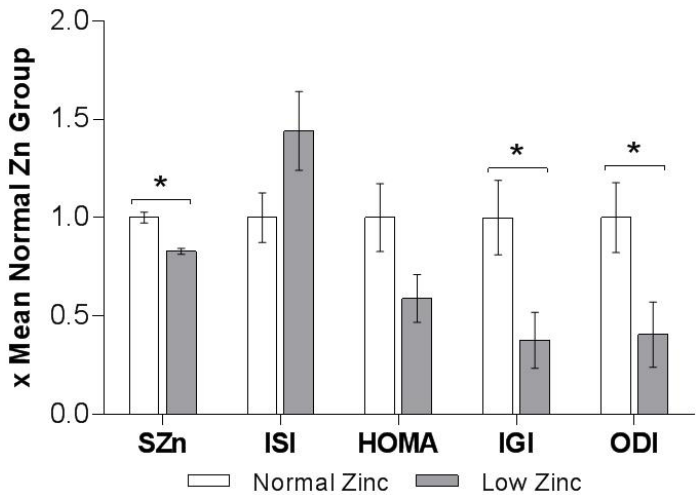
Figure 2. Oral glucose tolerance test derived indices of insulin sensitivity and beta xell function in normal ( n = 20) and low zinc ( n = 10) groups. All indices were normalized to mean of 1 for the normal zinc group and shown as mean ± SEM. * indicates statistically significant difference by unpaired t -test ( p < 0.05). SZn: Serum Zn, ISI: insulin sensitivity index